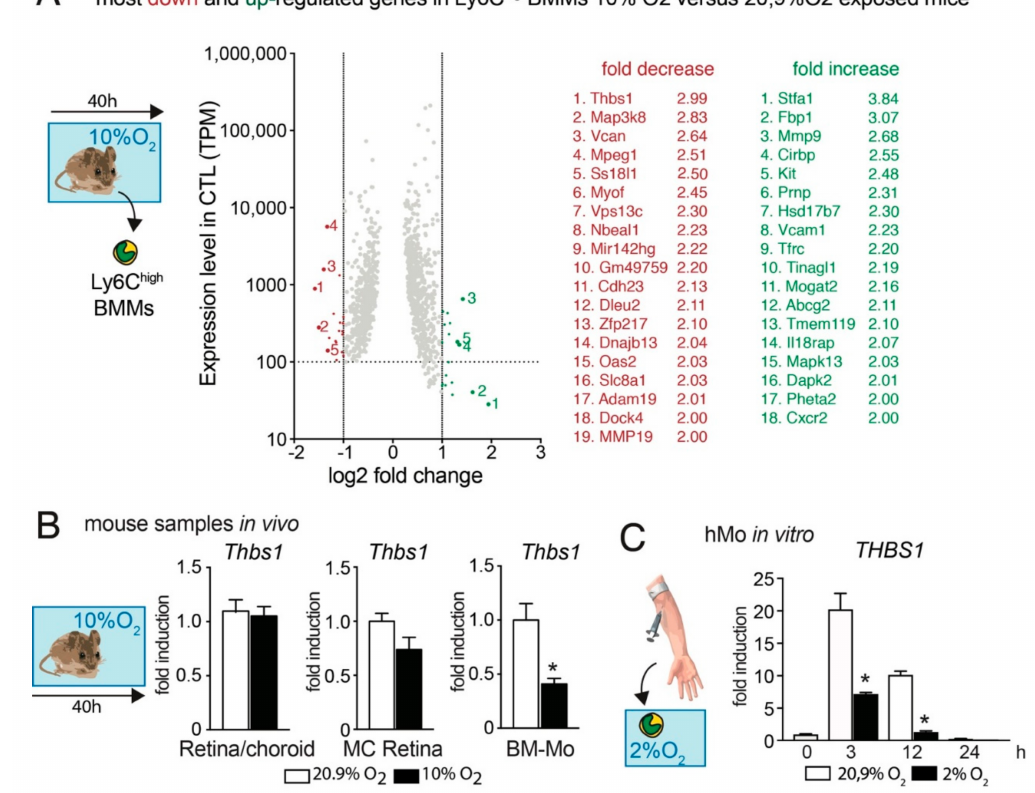
Figure 2. Hypoxia decreases Thbs1- expression in Mos. ( A ) Scatter dot blot of the protein coding mRNAs of FACS sorted CD45 + CD11B + Ly6G neg Ly6C high Mos from bone marrows of five 3-month-old mice that were raised in room-air or five age-matched mice that had been exposed to 10% ambient O 2 for 40 h. Only transcripts with a TPM greater than 100 in the normoxia group and a false discovery rate (FDR) smaller than 0.05 are depicted. The transcripts are plotted according to their expression levels ( y -axis) and the log2-fold induction by hypoxia (x axis). The identified 18 transcripts that were more than two-fold overexpressed and the 19 transcripts that were more than two-fold under- expressed in Mos from hypoxic mice compared to Mos from room air raised mice are indicated. ( B ) Quantitative RT-PCR of Retina/RPE/Choroid, magnet sorted retinal microglial cells (MC), and magnet sorted bone marrow monocytes (BM-Mo) from room-air-(white columns) and 40 h hypoxia- (10% O 2 ; black columns) exposed mice. ( n = 5 mice/group * p = 0.0032; Mann–Whitney versus the normoxic control). ( C ) Quantitative RT-PCR of human Mo exposed to normoxic culture conditions (white columns) or the indicated hours of 2% O 2 (black columns) ( n = 5 wells/group, representative of two independent experiments, * p = 0.0079 (3 h) and 0.0159 (12 h); Mann–Whitney versus the normoxic control). All values are reported as mean ± SEM. Thbs1: Thrombospondin